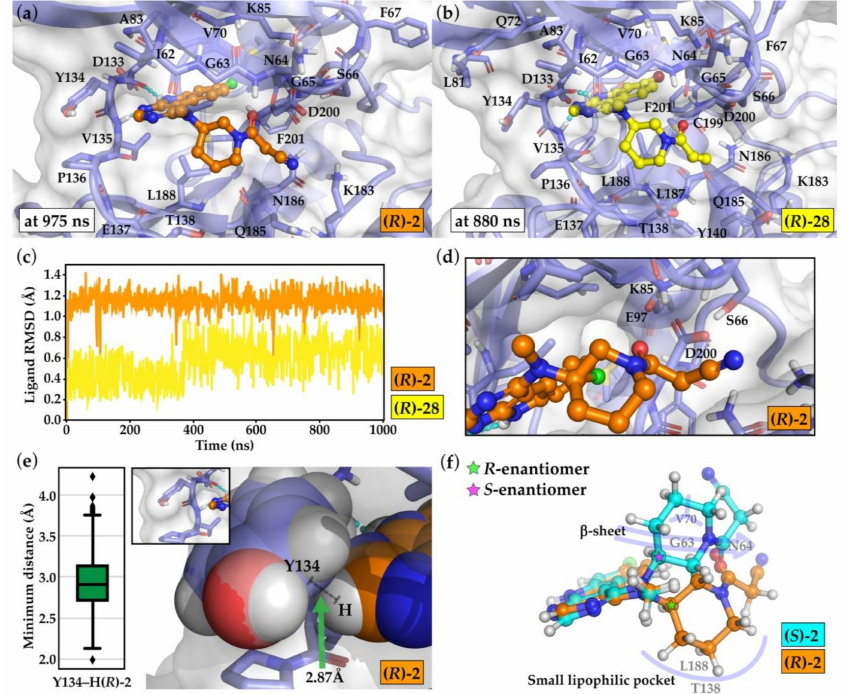
Figure 2. Putative binding mode of the described GSK3 β inhibitors: ( a ) representative snapshot of the (R) -2 binding conformation during the 1 µ s molecular dynamics (MD) simulation. All residues located within 4 Å of the ligand during the simulation are shown as sticks. Hydrogen bonds are depicted with cyan dashed lines; ( b ) representative snapshot of the (R) -28 binding conformation during the 1 µ s MD simulation; ( c ) the ligands appear extremely stable in the shown conformation throughout the simulations as demonstrated by their root-mean-square deviation (RMSD) values; ( d ) the carbonyl oxygen points towards the polar residues Asp200, Lys85, Ser66, and Glu97 but does not form any specific direct interactions with GSK-3 β ; ( e ) the proton in the 2-position of the pyrimidine ring is in close proximity to the side chain of Tyr134. Here, the conformation of ( a ) is illustrated, where the distance is 2.87 Å. The (R) -2 and Tyr134 atoms are shown as spheres representing their van der Waals radius; and ( f ) comparison of the preferred quantum mechanics (QM)-derived conformations of the di ff erent enantiomers of 2 . (S) -2 is unable to obtain the binding conformation as observed for (R) -2 . In the preferred (S) -2 conformation, the piperidine ring would clash with the β -sheet and Val70 and would not occupy the small lipophilic pocket formed by Leu188 and